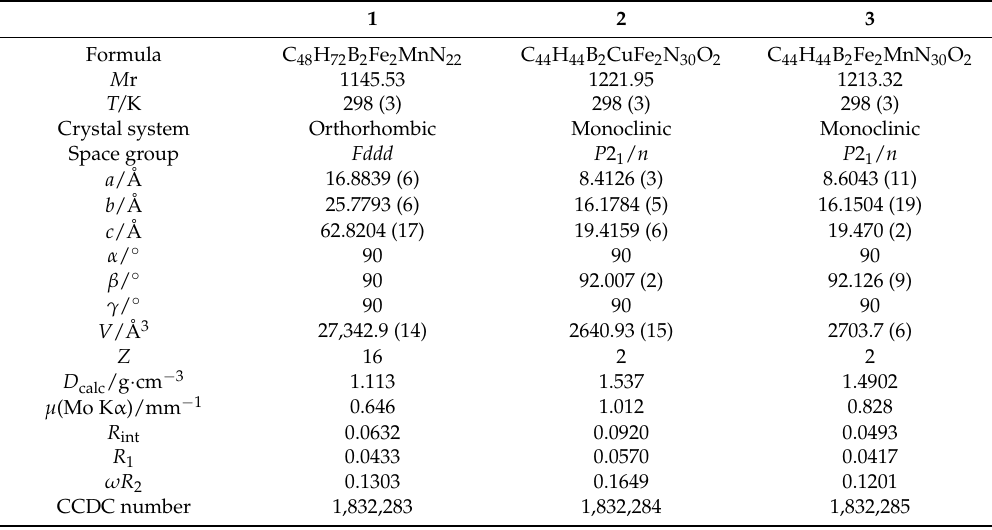
Table 1. The crystalline data and refinement parameter for complexes 1 – 3